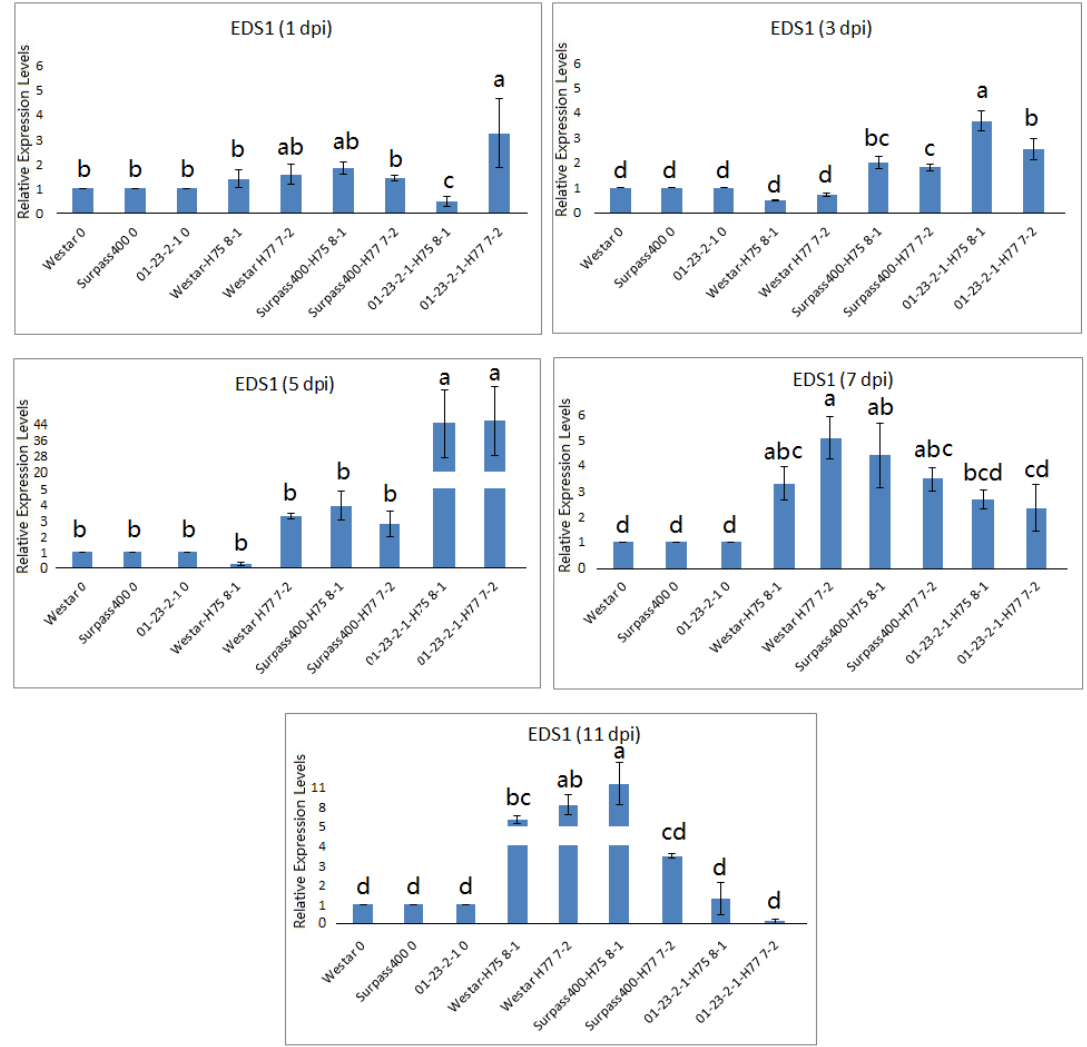
Figure 5. Expression analysis of genes related to cell death ( PAD4 and EDS1 ). The level of the bars are the expression levels from the inoculated cotyledons (three genotypes: Westar, Surpass400 and 01-23-2-1, two isolates: H75 8-1 and H77 7-2) normalized with the cotyledons inoculated with water (assuming that the expression of each studied gene in the cotyle- dons inoculated with water is 1). For the time point, different lowercase letters suggest the significant differences among mean values (Fisher’s Least Significant Difference; p < 0.05). The results are based on three replicates in three independent experiments.